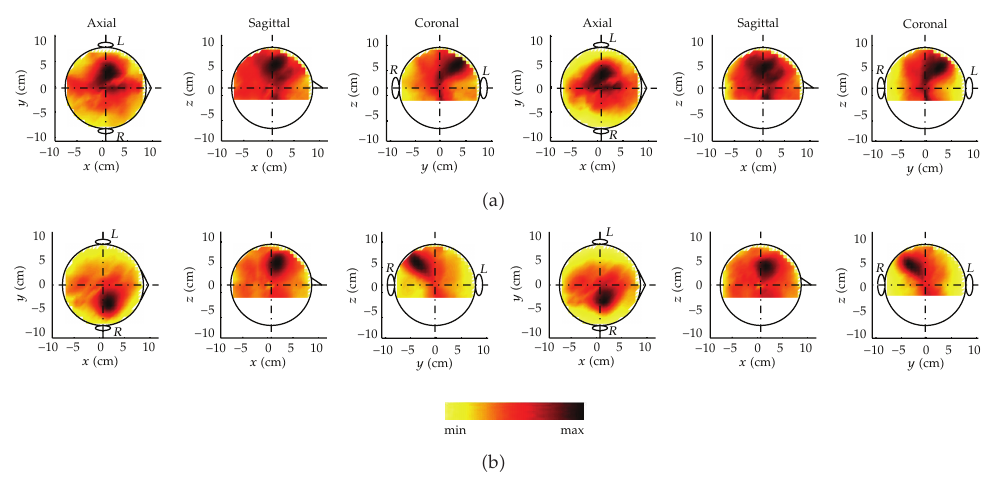
Figure 8: Averaged-over-trial-reconstructed source power maps of both conventional beamformer (cid:2) left (cid:3) and reduced scanning beamformer with our proposed strategy (cid:2) right (cid:3) for empirical median nerve stimulation data. (cid:2) a (cid:3) Right-hand movement. (cid:2) b (cid:3) Left-hand movement.